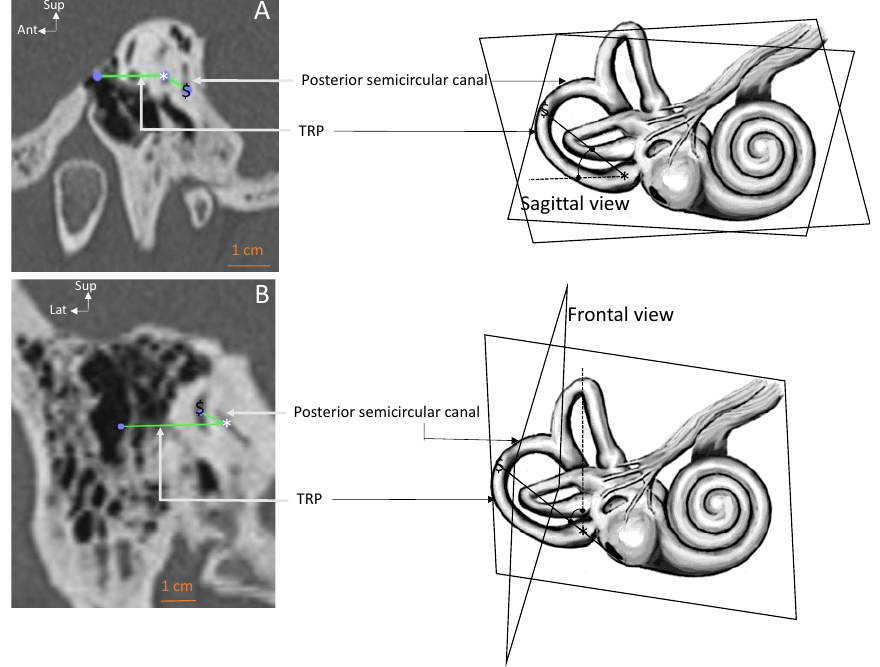
Figure 4. Angle measurements for the posterior semicircular canal (SCC) in the transverse ( A ) and